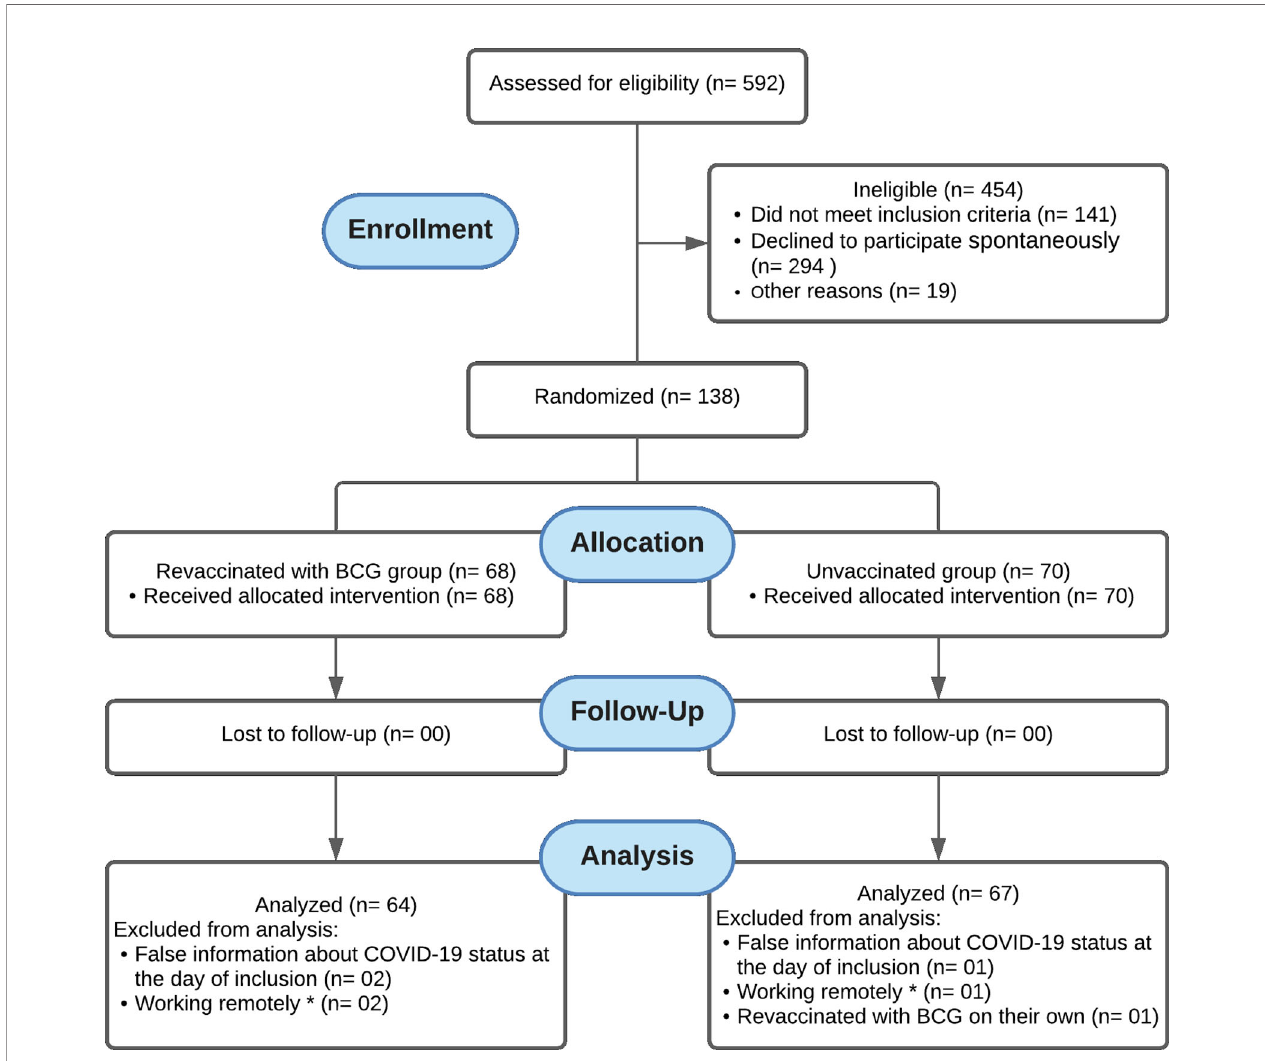
unvaccinated group. There was no loss to follow-up in neither group. In the revaccinated BCG group, two participants were excluded from analysis due to false information about COVID-19 status on the day of inclusion, and another two were excluded for working remotely, remaining 64 participants for analysis. In the unvaccinated group, one participant was excluded from analysis due to false information about COVID-19 status on the day of inclusion, another one was excluded for working remotely, and one was excluded for having been vaccinated with BCG on their own, leaving 67 participants for analysis. * Health care workers in remote jobs refers to HCWs who were not working for at least eight hours per week under exposure to those suspected of being infected with